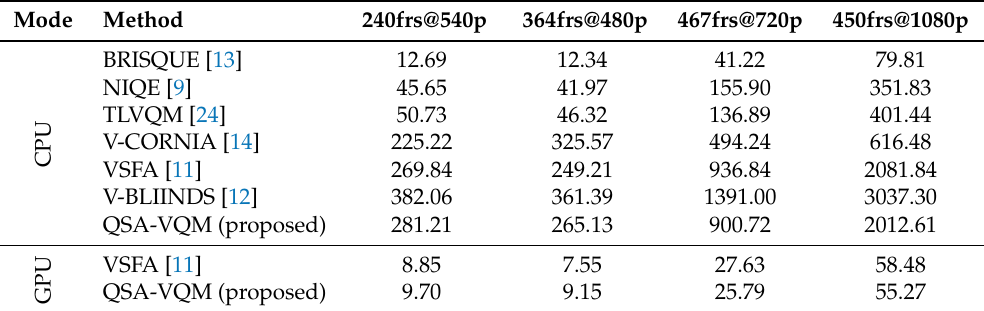
Table 4. Computation time comparison in seconds for four videos selected from the considered databases. {xxx}frs@{yyy}p indicates the video frame length and the resolution,